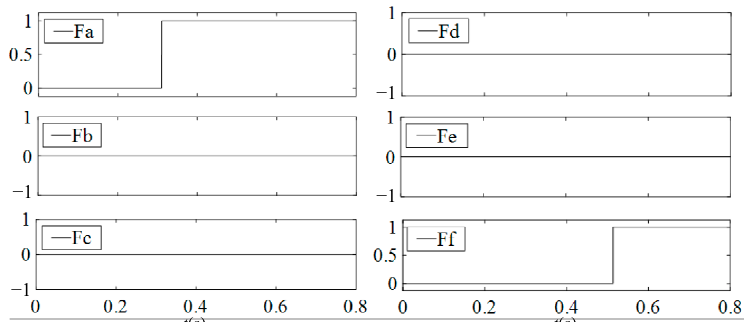
Figure 15. Current waveforms of phase a and phase f at 0.3 s and 0.5s open-circuit fault, respectively.